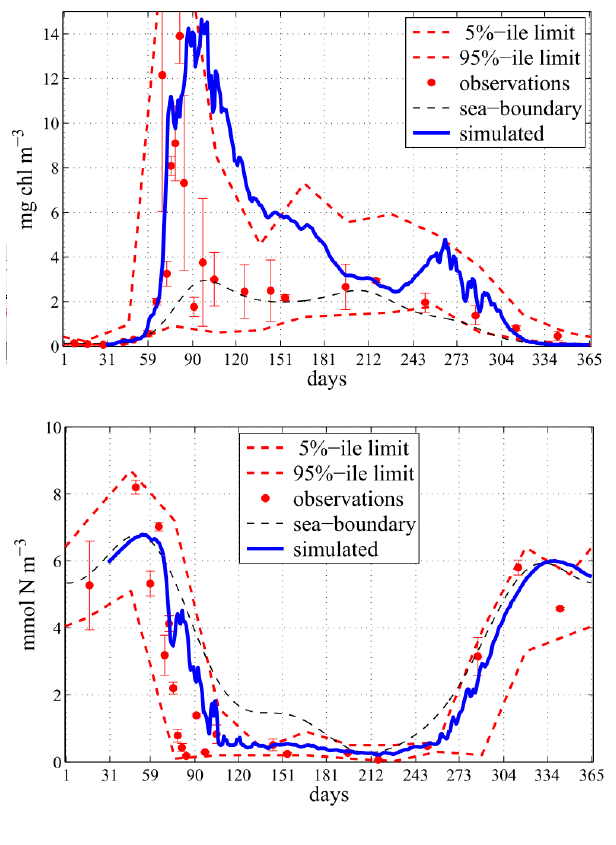
Fig. 5 . Test of the physical-biological model against data for Loch Creran. The simulation does not satisfy the strong test of fitting well to the 1975 observations (c.f. Portilla et al. 2009) but does satisfy the weaker tests of falling (mostly) within the climatological envelopes and matching expectations of the seasonal cycle.